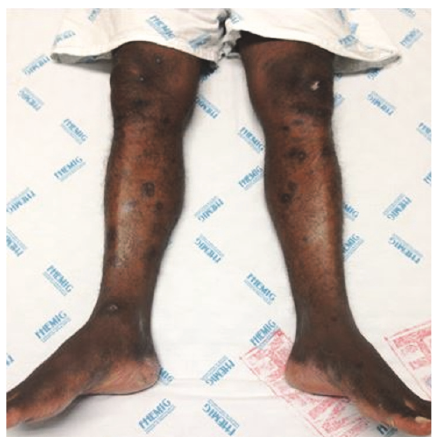
Figure 2: Case 2: patient without edema after recovered DVT in both